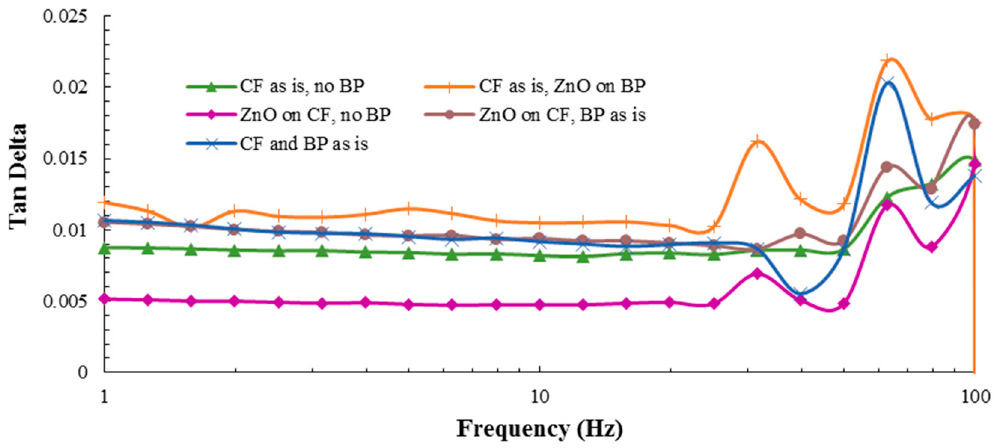
Figure 11. The variation of tan ( δ ) with frequency at 30 °C for the various composite configurations.